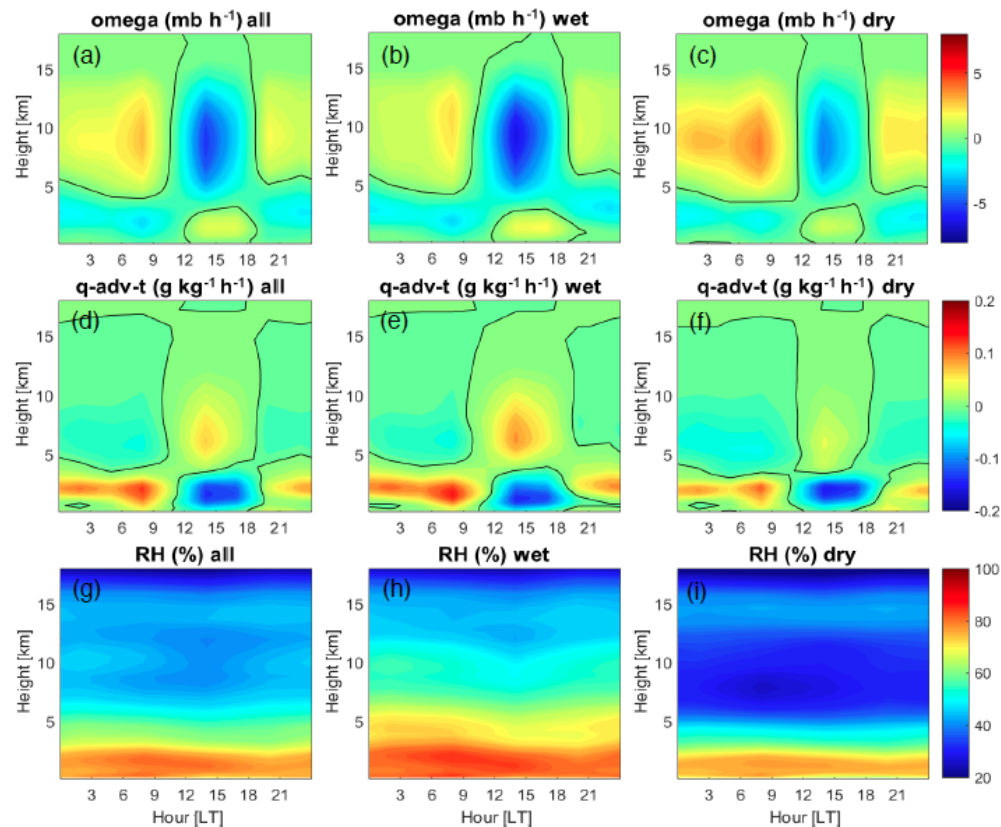
Figure 4. Diurnal cycles of omega, total advection of moisture and relative humidity (with respect to liquid) for the complete 2-year GoA- mazon2014/15 campaign record (a, d, g) , as well as wet season (b, e, h) and dry season (c, f, i)